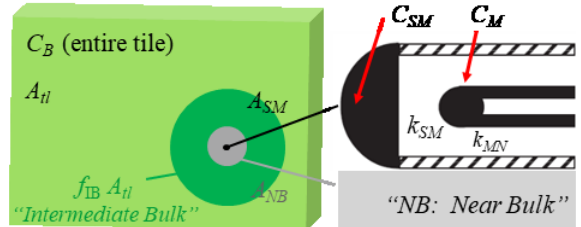
Fig. 7. Complete assembly of a reflecting grating, tungsten coated and equipped with thermocouples. Left photo: plasma facing side, width and height approx. 20 cm and 18 cm. The four large openings are for attaching the tile to the heat shield. Right: magnified area around a 0.5 mm borehole, containing a flush mounted thermocouple with a diameter of 0.25 mm.